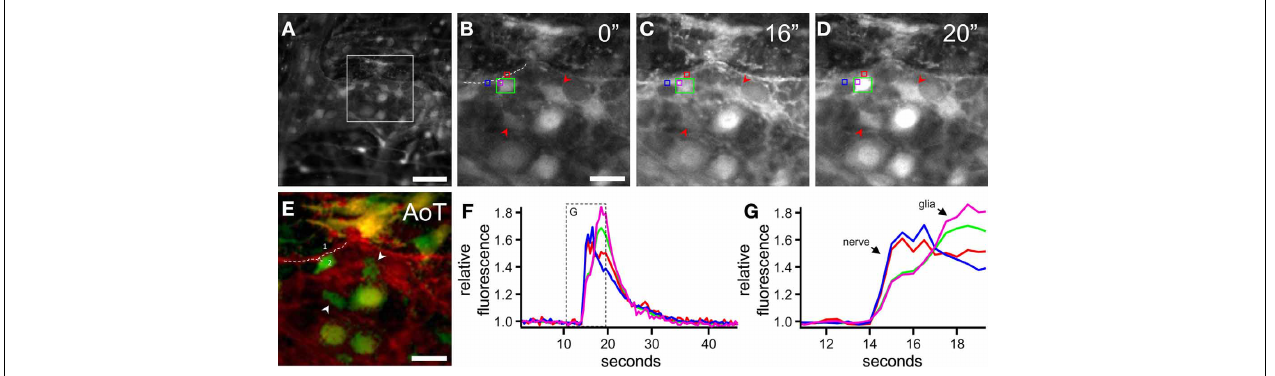
FIGURE 4 | Detection of neuronal vs. glial signals in ex vivo enteric nervous system preparations. (A) Gray scale image of a colonic myenteric plexus ganglion loaded with Fluo4 at rest. (B–D) Magnification of the square region marked in (A) before (B) and after (C,D) electrical stimulation (ETS, 2s, 20Hz) of an interganglionic connective. (E) Activity over time (AoT) image of the region in which pixels responding immediately (red) or with a delay (green) to ETS are false colored. Arrowheads point to enteric glial cells that display a Ca 2 +